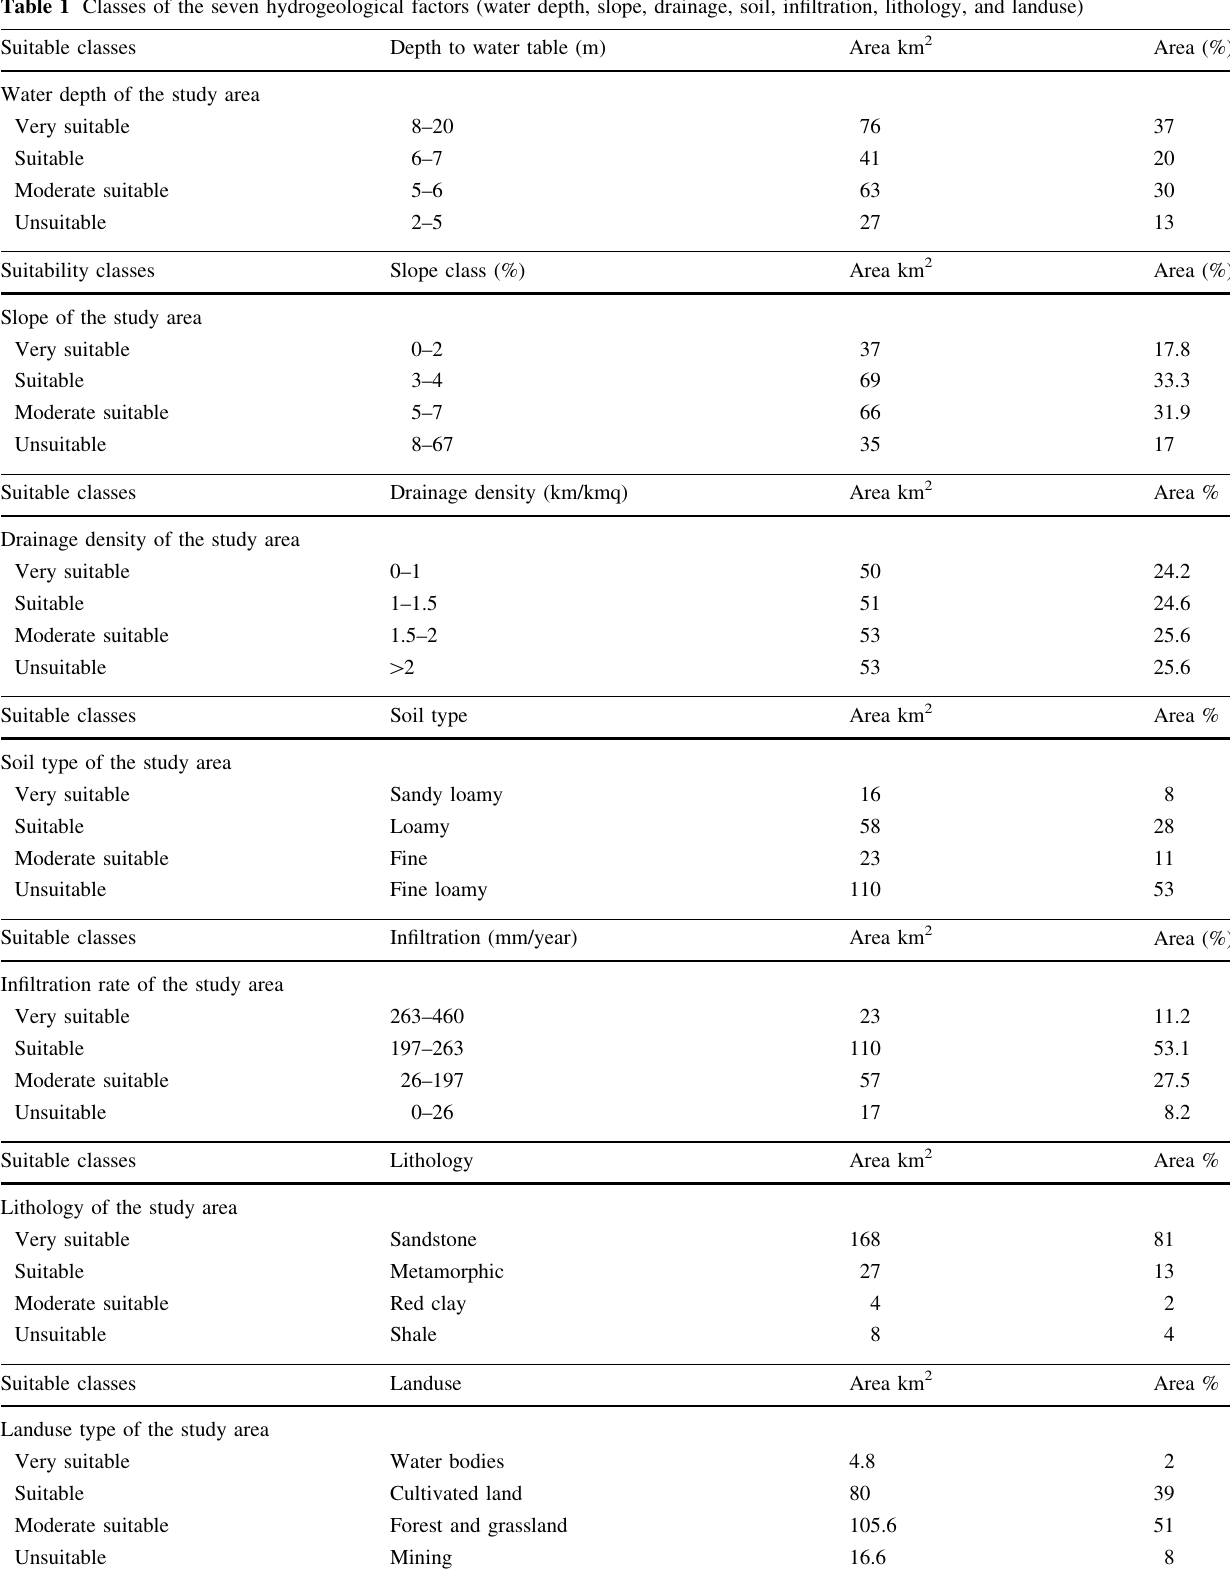
Table 1 Classes of the seven hydrogeological factors (water depth, slope, drainage, soil, infiltration, lithology, and